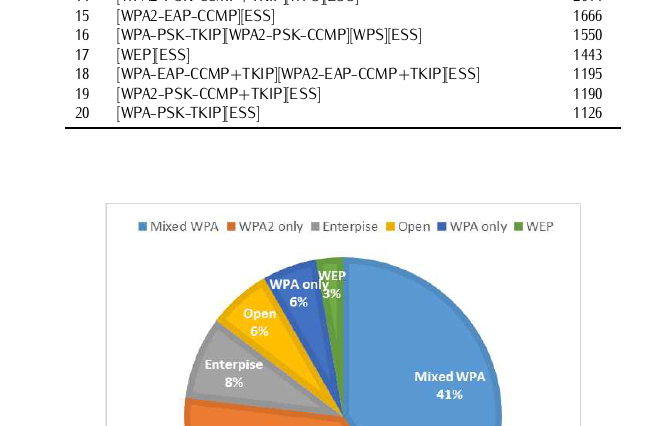
Figure 4. Bucharest area wireless security overview in 2012 vs 2016